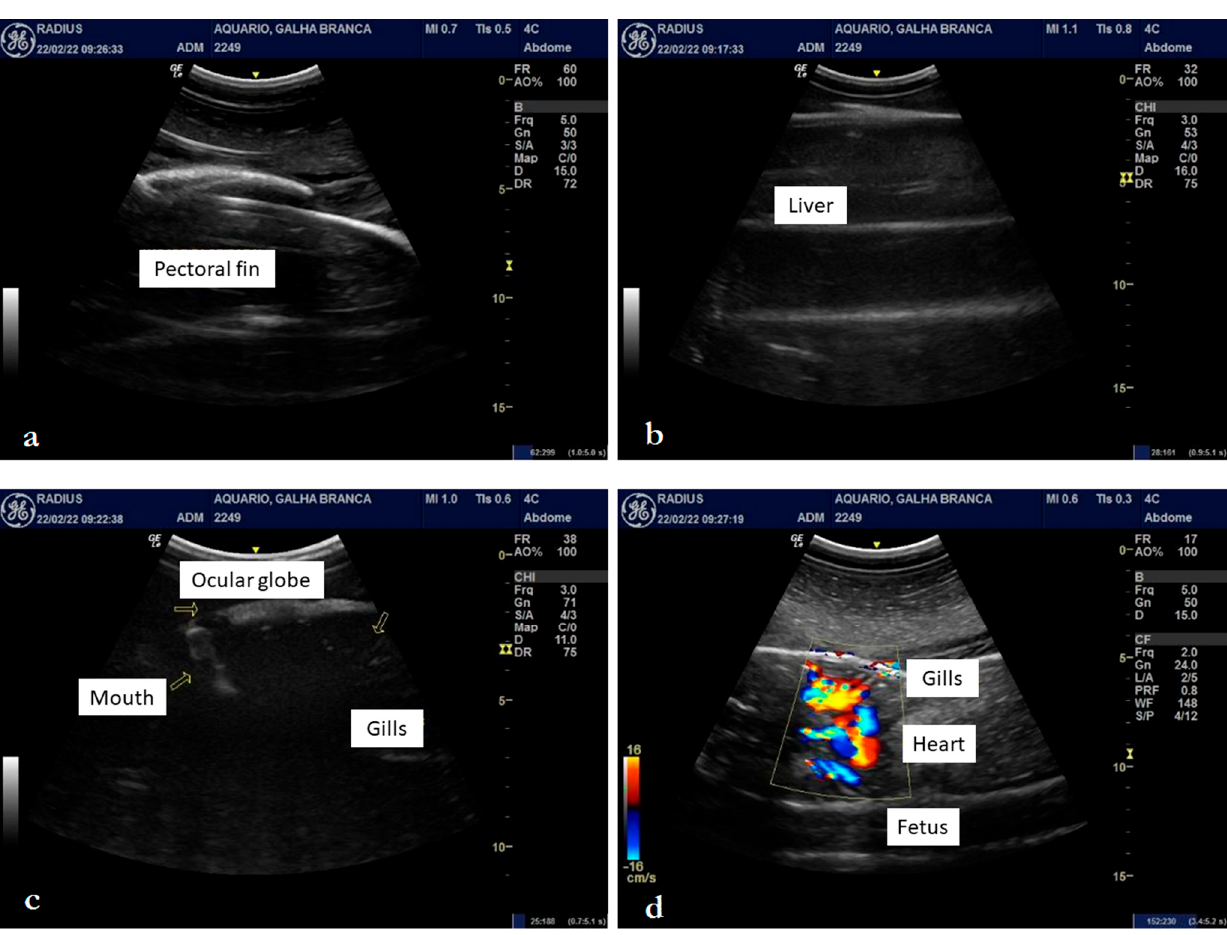
Figure 1. Basic internal anatomy of a carcharhinid shark ( Carcharhinus melanopterus ), showing the location of principal organs. Adapted from Crow and Brock [32].